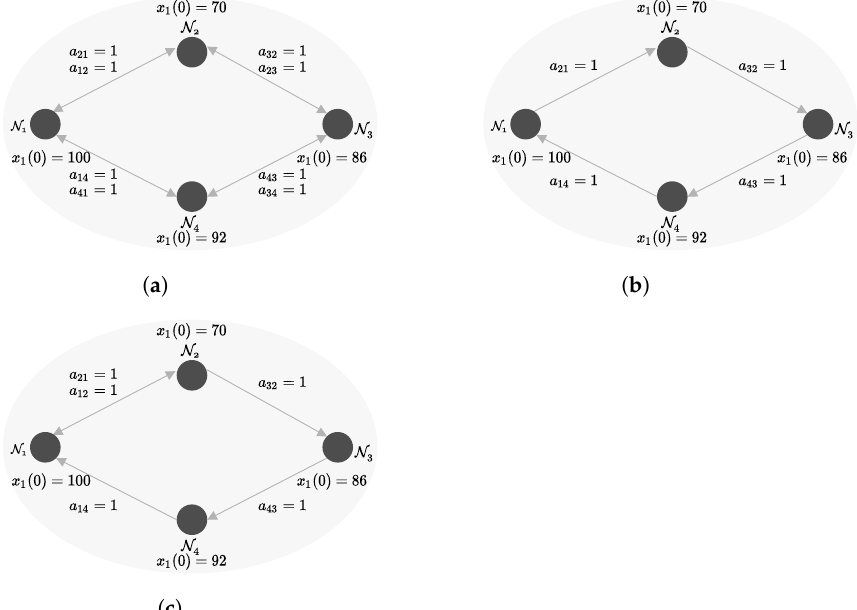
Figure 7. Different communication topology for the group of engineers in the example of Figure